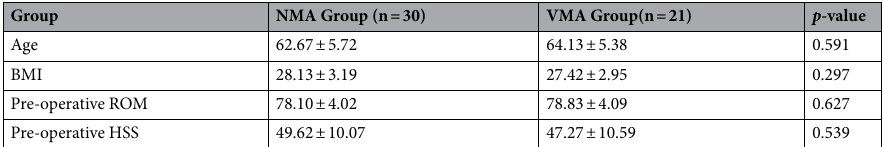
Table 1. Pre-operative baseline characteristics for all patients, grouped according to post-operative mechanical alignment. The values are given as the mean and the standard deviation. NMA group neutral